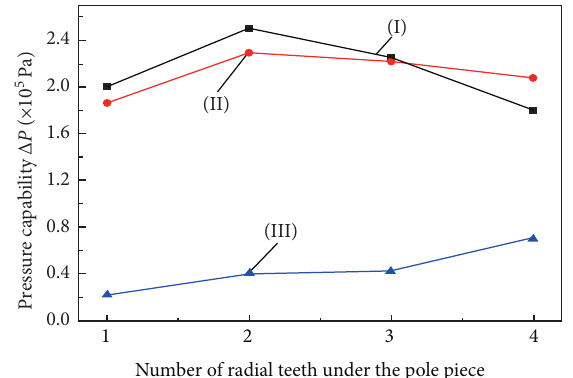
Figure 12: Influence of radial teeth number on pressure resistance ability of magnetic fluid seal. (I) Experimental value of divergent magnetic fluid seal. (II) Theoretical value of divergent magnetic fluid seal. (III) Experimental value of ordinary magnetic fluid seal.